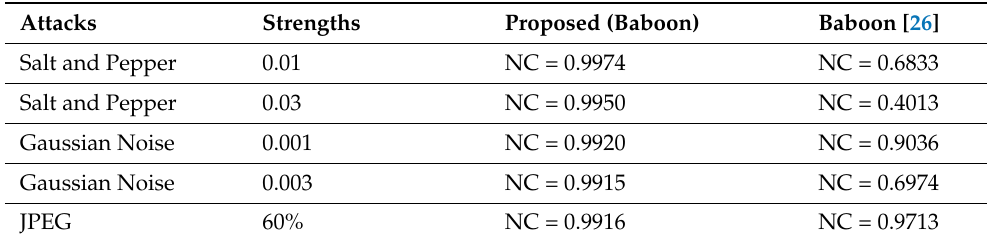
Table 7. Normalized correlation against processing